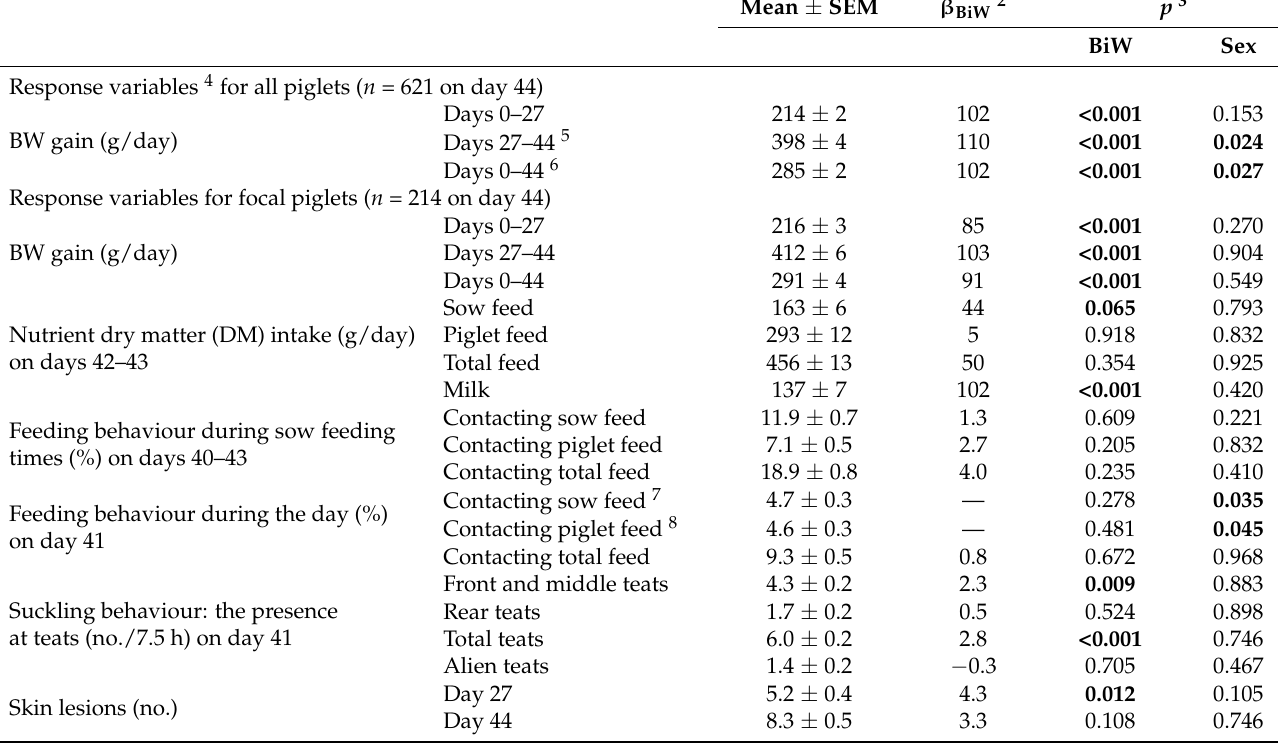
Table 1. Results of the linear regression analysis between response variables and birthweight (BiW, kg) in all piglets and focal piglets 1 up to day 44 of lactation in the multi-suckling (MS)